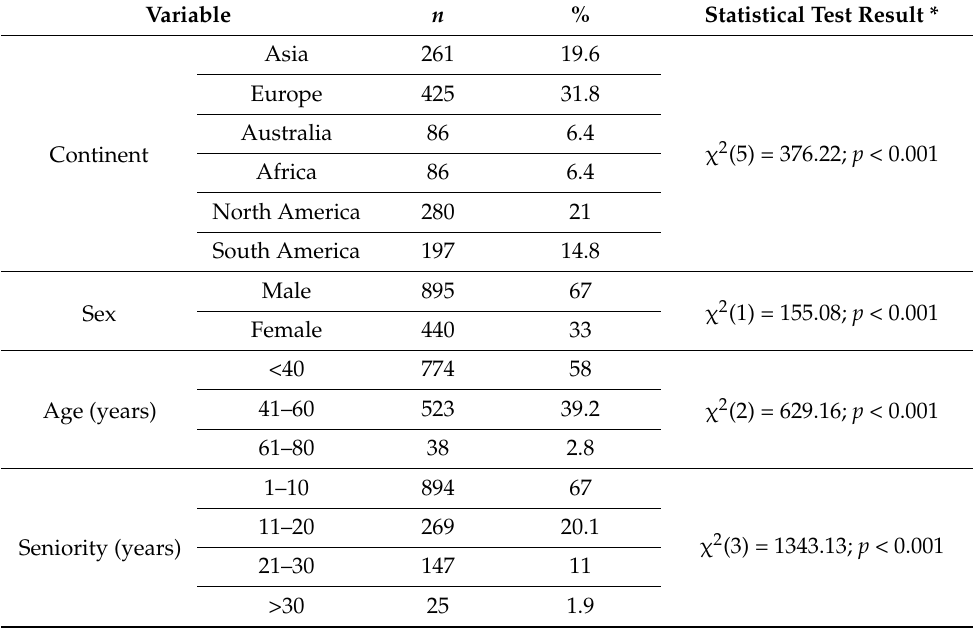
Table 1. Sociodemographic data of the surveyed group of